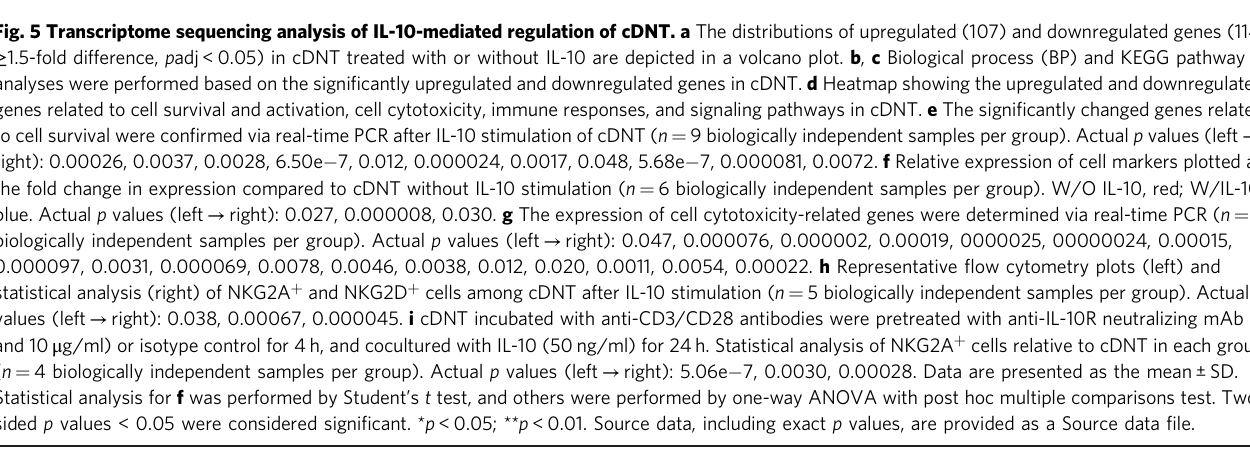
Fig. 5 Transcriptome sequencing analysis of IL-10-mediated regulation of cDNT. a The distributions of upregulated (107) and downregulated genes (114; ≥ 1.5-fold difference, p adj< 0.05) in cDNT treated with or without IL-10 are depicted in a volcano plot. b , c Biological process (BP) and KEGG pathway analyses were performed based on the signi fi cantly upregulated and downregulated genes in cDNT. d Heatmap showing the upregulated and downregulated genes related to cell survival and activation, cell cytotoxicity, immune responses, and signaling pathways in cDNT. e The signi fi cantly changed genes related to cell survival were con fi rmed via real-time PCR after IL-10 stimulation of cDNT ( n = 9 biologically independent samples per group). Actual p values (left → right): 0.00026, 0.0037, 0.0028, 6.50e − 7, 0.012, 0.000024, 0.0017, 0.048, 5.68e − 7, 0.000081, 0.0072. f Relative expression of cell markers plotted